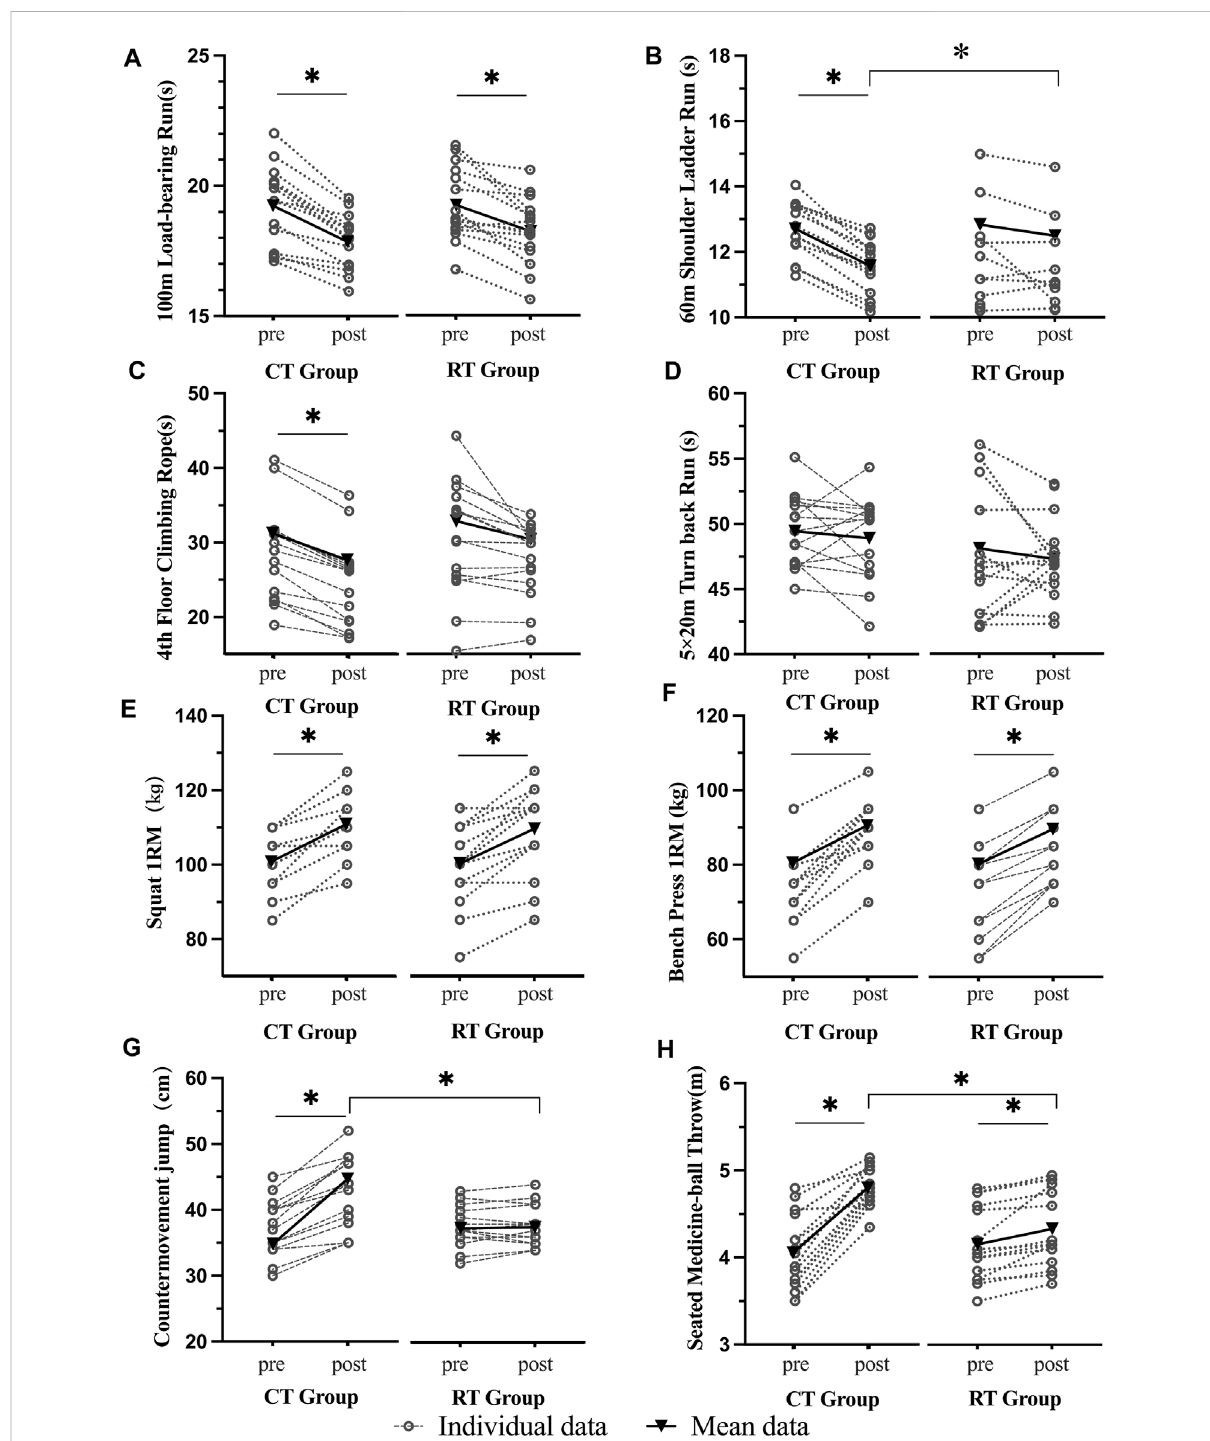
FIGURE 2 The task performance before and after Complex Training (CT) and Resistance Training (RT). Each spot on the fi gure re fl ected one participant, and the mean of each group was presented. Note: * p <